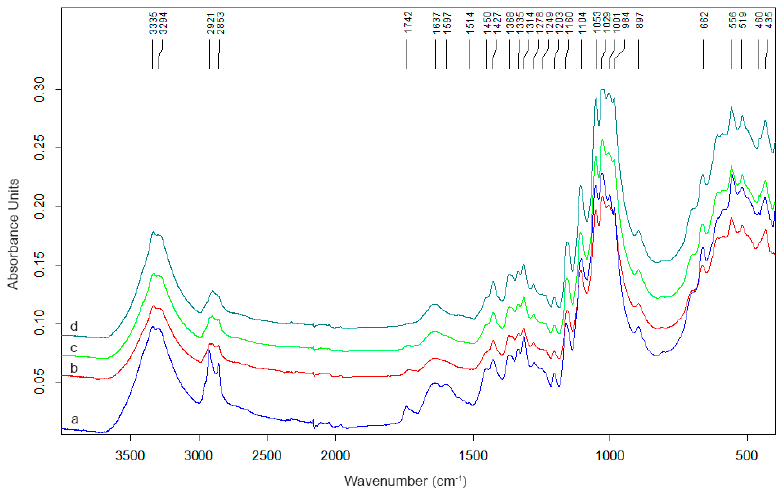
Figure 6. Infrared spectra of neat (a) and enzymatically modified flax yarns using 10 wt % Peclyve for 3 h (b), 4.5 h (c) and 6 h (d).